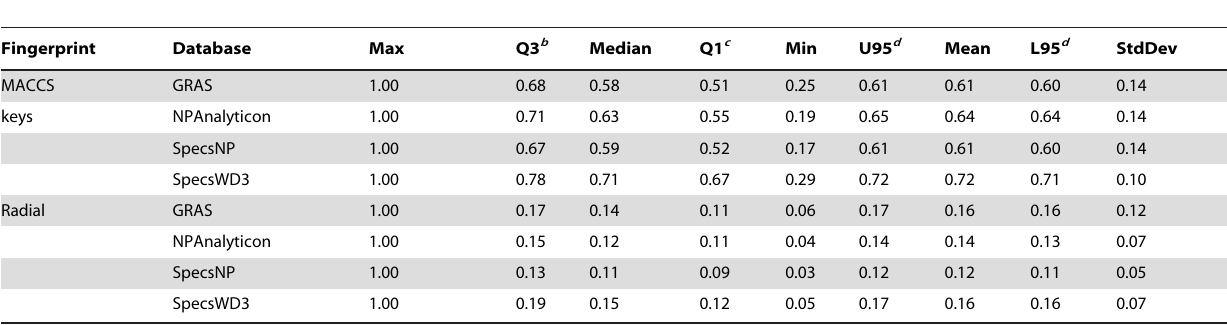
Table 3. Summary of the comparison between DrugBank and the other four databases computed with MACCS keys and radial fingerprints.